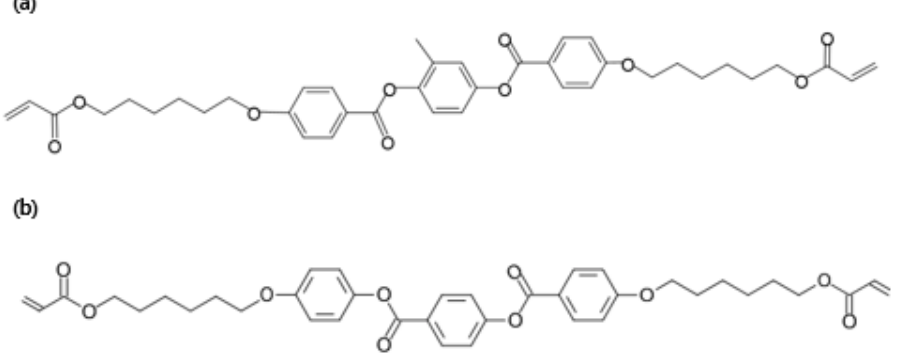
Figure 1. Chemical structure of the ( a ) nematic RM (HCM009) and the ( b ) smectic RM (HCM026) molecules used in this study.